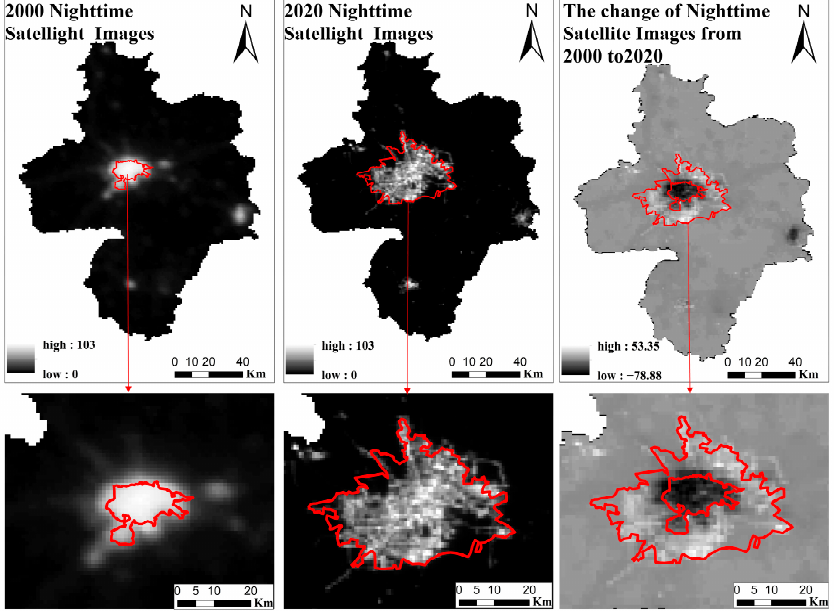
Figure 10. Comparison of the night in Hefei from 2000 to 2020 from the global and local viewpoints, respectively.